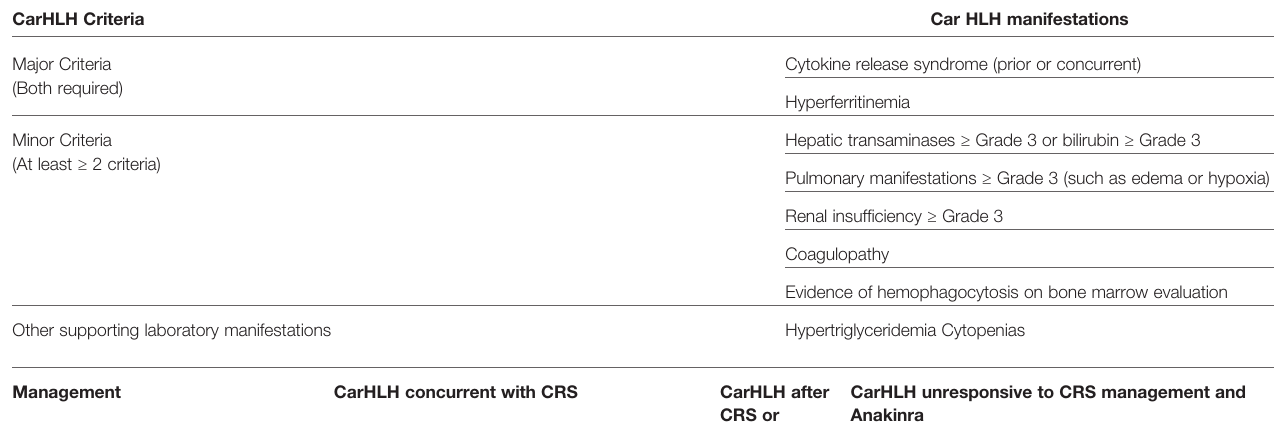
TABLE 7 | CarHLH manifestations and management. CarHLH